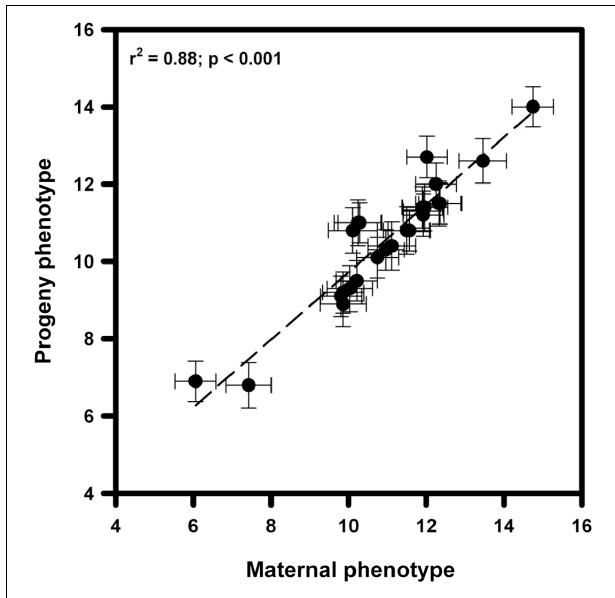
FIGURE 5 | Heritability of the ESCP in Taraxacum officinale seeds from 25 populations belonging to five localities distributed along a latitudinal gradient. Means of the relationship between the maternal phenotype and the offspring phenotype of nine seeds per population are shown.